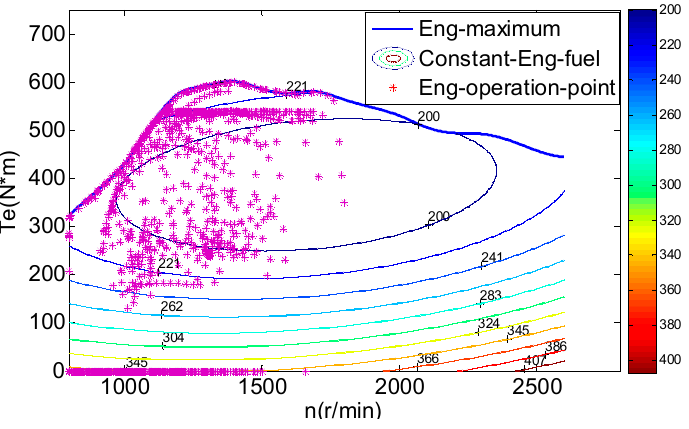
Figure 19. Distribution of the engine operating point (Rule-based).